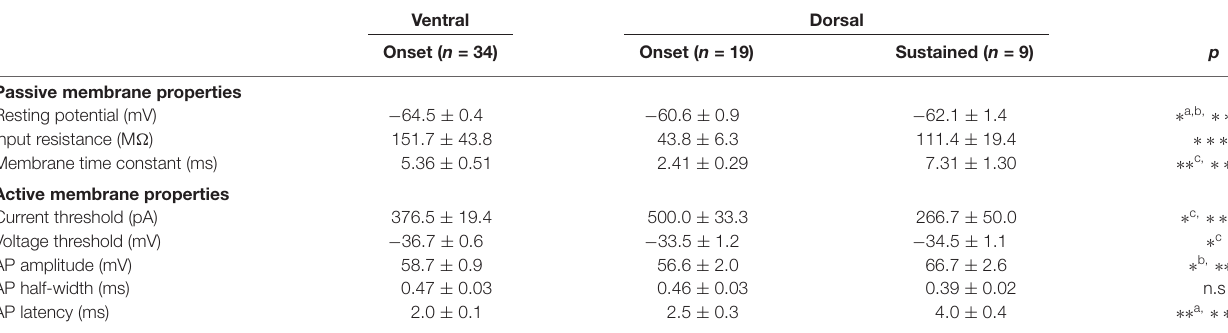
TABLE 1 | Summary of membrane properties of dVNLL and vVNLL